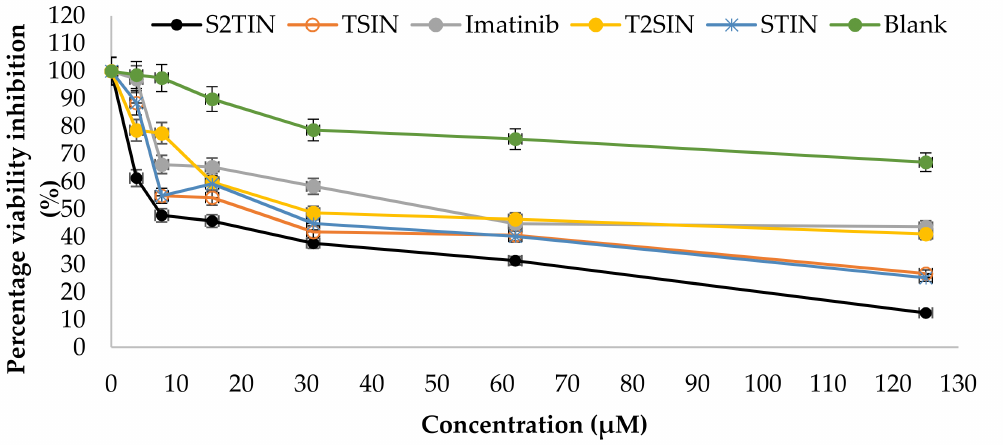
Figure 6. Cytotoxicity of IMA (pure) and its formulations at 72 h. Values are represented as the average of three